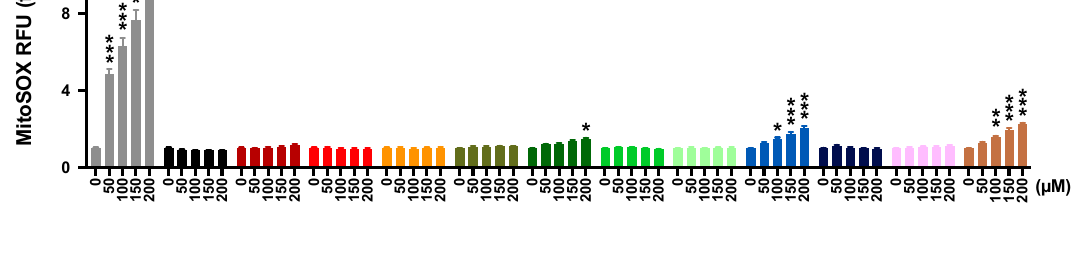
Figure 3. Effect of test compounds on mitochondrial superoxide production. Cells were exposed to reference (antimycin A, idebenone) or test compounds (0–200 μ M) for 30 min before mitochondrial superoxide levels were quantified. Data was expressed as mean ± SEM of 3 independent experiments with 8 parallel wells per experiment. Two-way ANOVA was performed to compare test concentrations against the non-treated control: *** p < 0.001, ** p < 0.002, * p < 0.033. Full datasets available in Table S7.